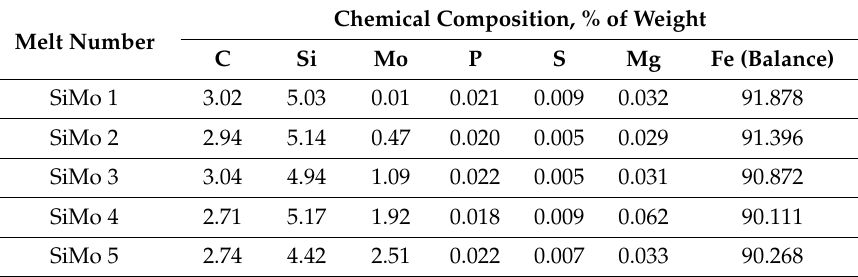
Table 1. Chemical composition of the tested SiMo cast iron.